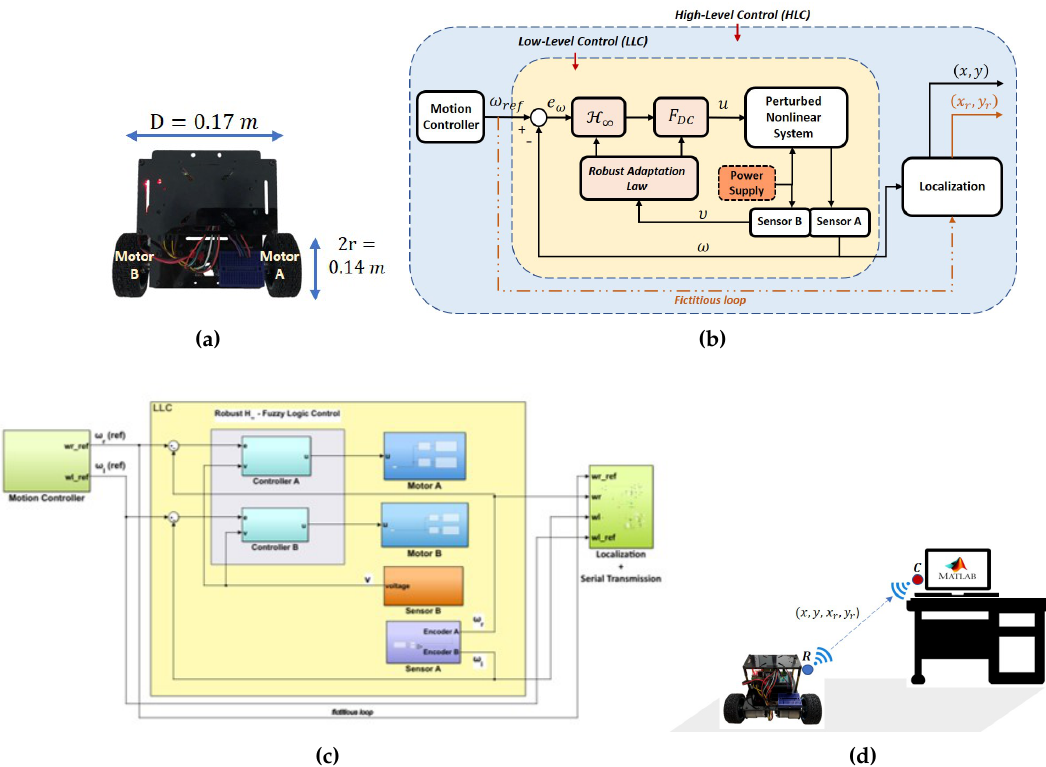
Figure 13. Data acquisition setup for the path tracking experiment with a WMR: ( a ) a sketch (not to scale) of the WMR; ( b ) overview of the proposed model-based control system; ( c ) the Simulink model that has been embedded into the WMR’s microcontroller unit; and, ( d ) a sketch (not to scale) of the wireless data acquisition process from the workstation during the experiment.